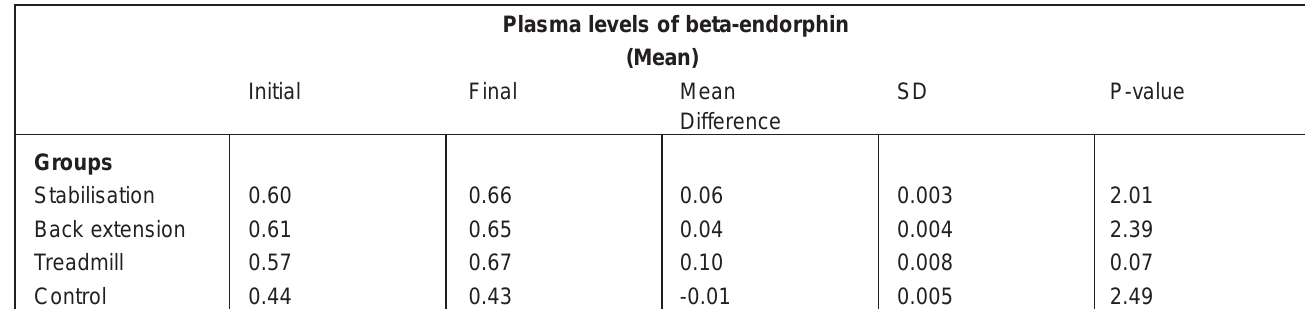
Table 3: Participants plasma levels of